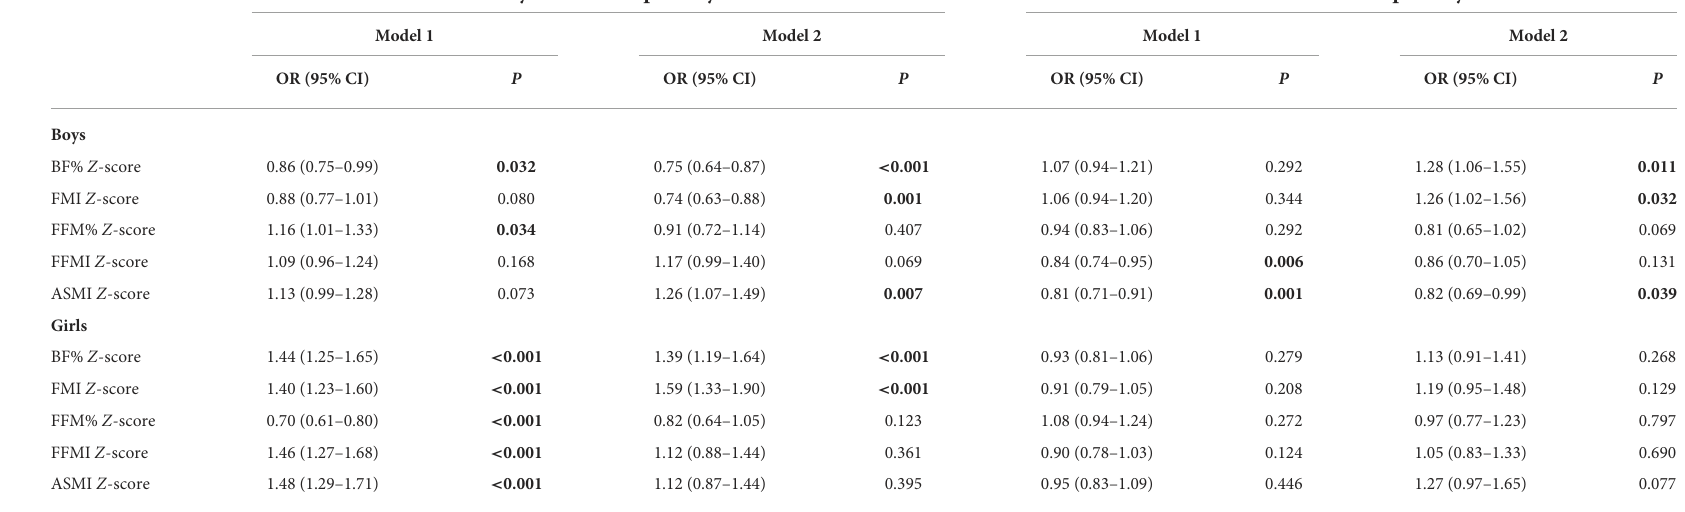
TABLE 3 Associations of body composition with pubertal timing in boys and